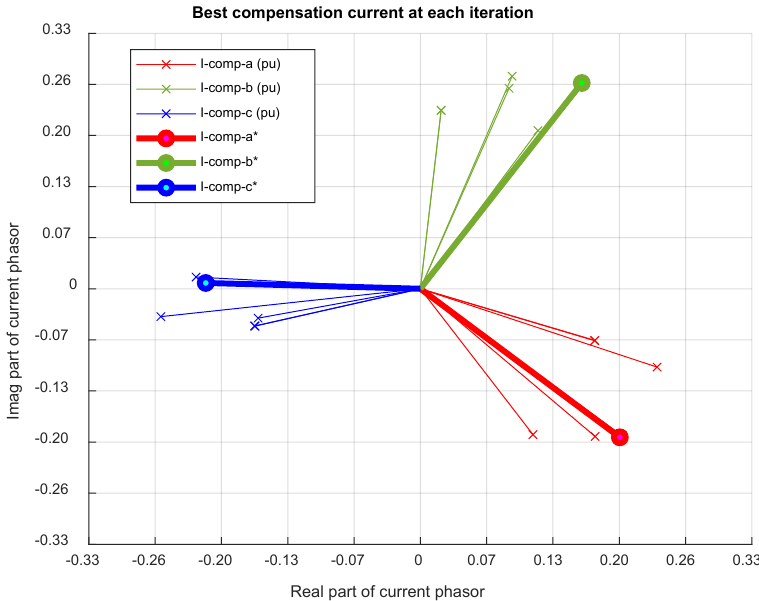
Figure 8. Best compensation current of each iteration in Case B. Table 5. Voltage unbalanced factor and voltage variation in Case B.